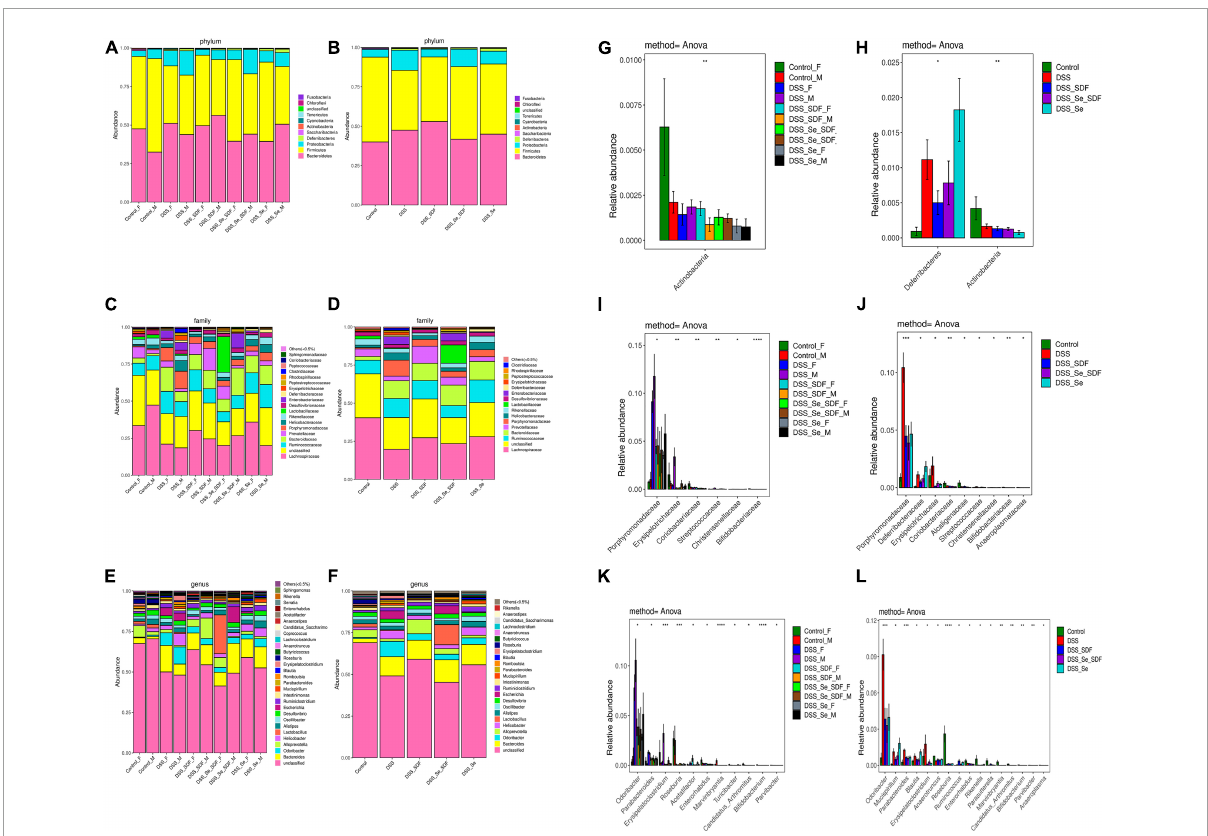
FIGURE5 Microbial taxonomic composition and bacterial taxonomic comparison. Analysis of microbial taxonomic composition and community differences at the phylum level in female and male groups (A,G) and the overall analysis of (B,H) . Analysis of microbial taxonomic composition at the family level in female and male groups (C,I) and the overall analysis of (D,J) . Analysis of microbial taxonomic composition at the genus level in female and male groups (E,K) and the overall analysis (F,L) . * p < 0.05, ** p < 0.01, *** p < 0.001, **** p < 0.0001.